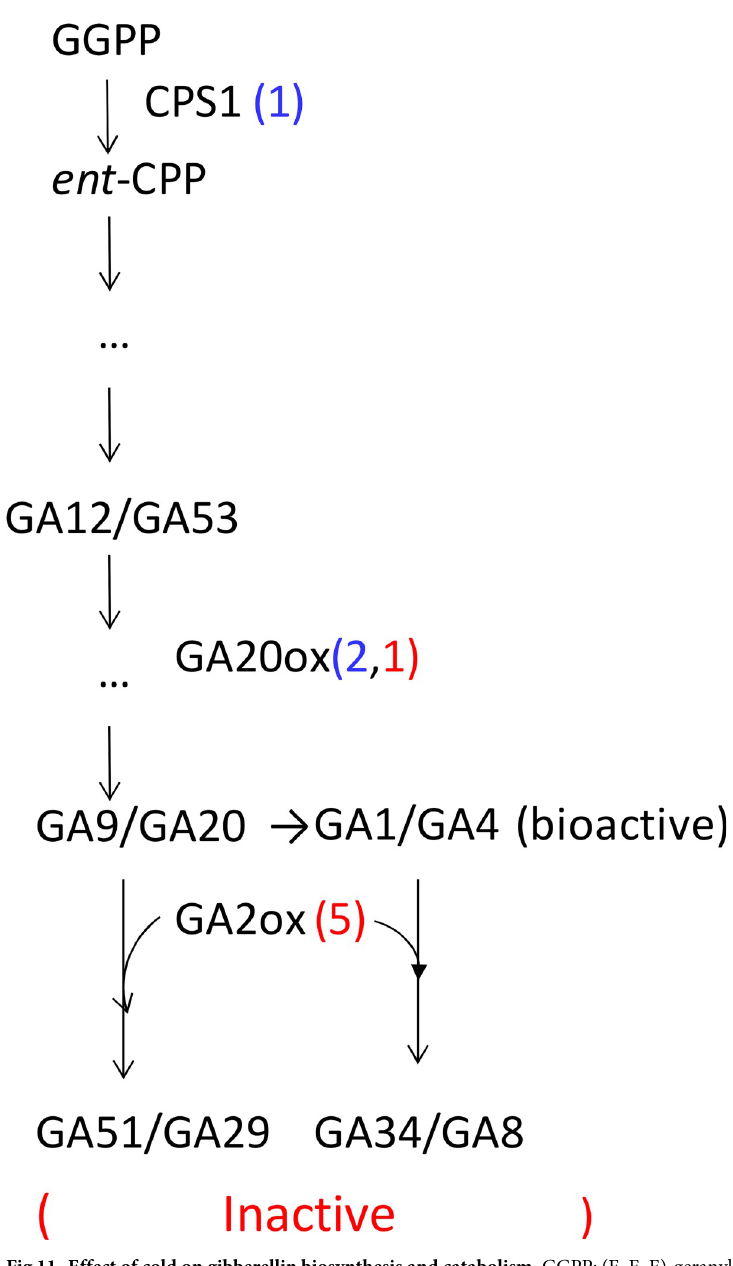
Fig 11. Effect of cold on gibberellin biosynthesis and catabolism. GGPP: (E, E, E)-geranylgeranyl diphosphate; CPP: ent -copalyl diphosphate; CPS1: ent -copalyl diphosphate synthase1; GA20ox: GA20-oxidase; GA2ox: gibberellin 2-oxidase.